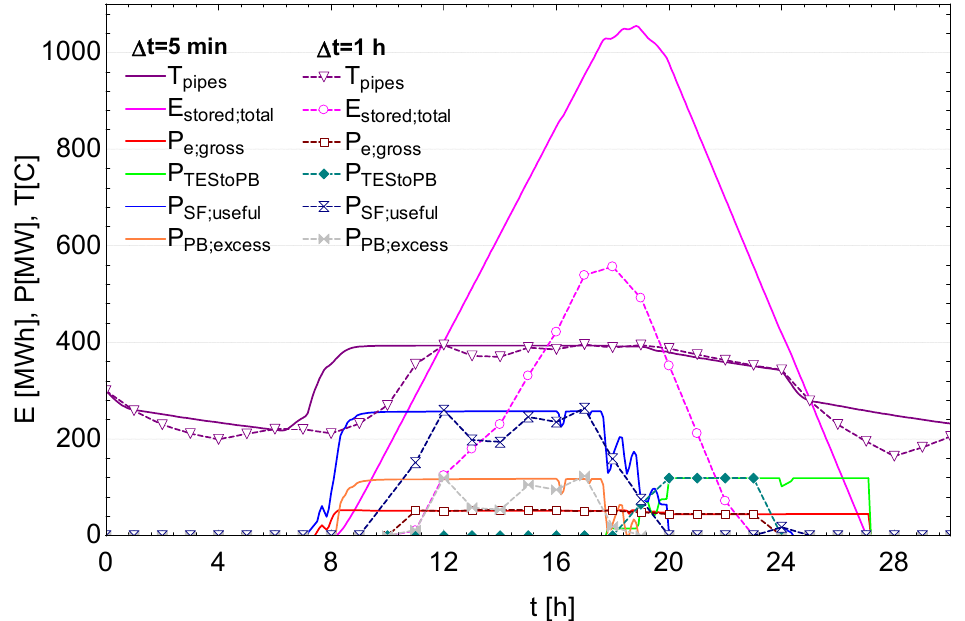
Figure 5. Comparison of the HTF temperature ( T pipes ), energy stored in the TES ( E stored ), gross